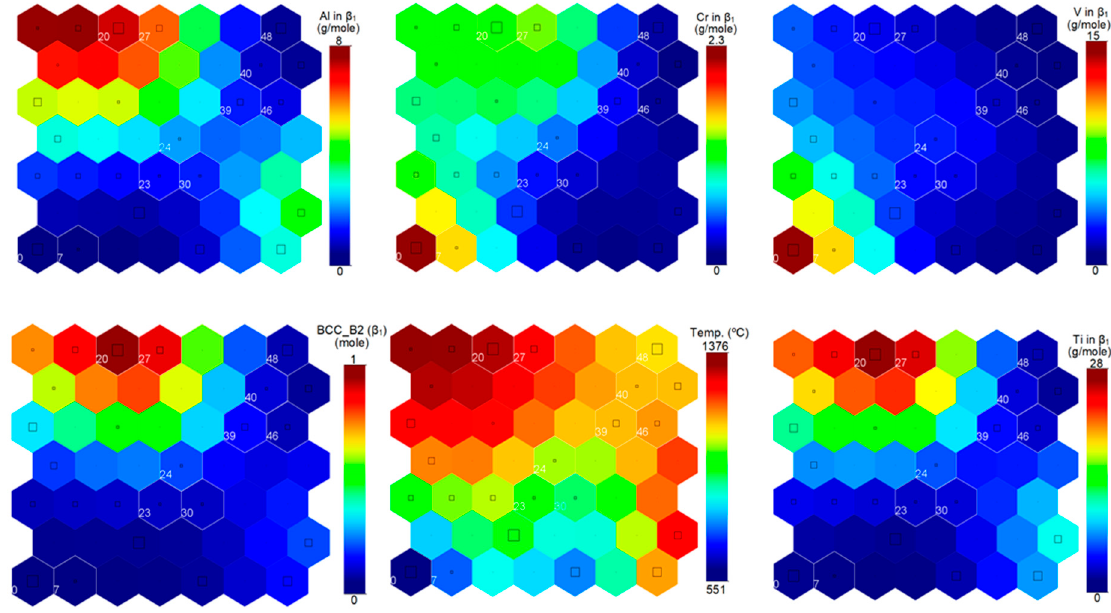
Figure 6. Distribution of alloying elements in BCC_B2 phase.